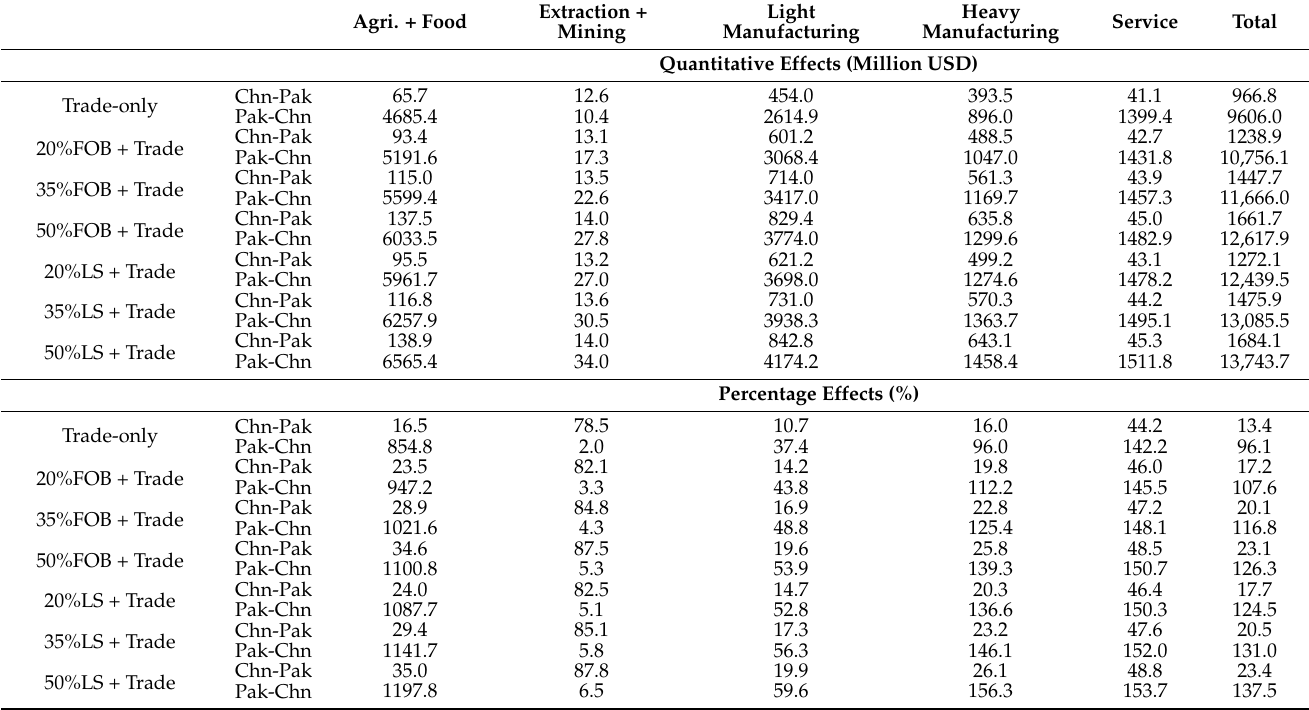
Table 6. Effects on bilateral trade between Pakistan and